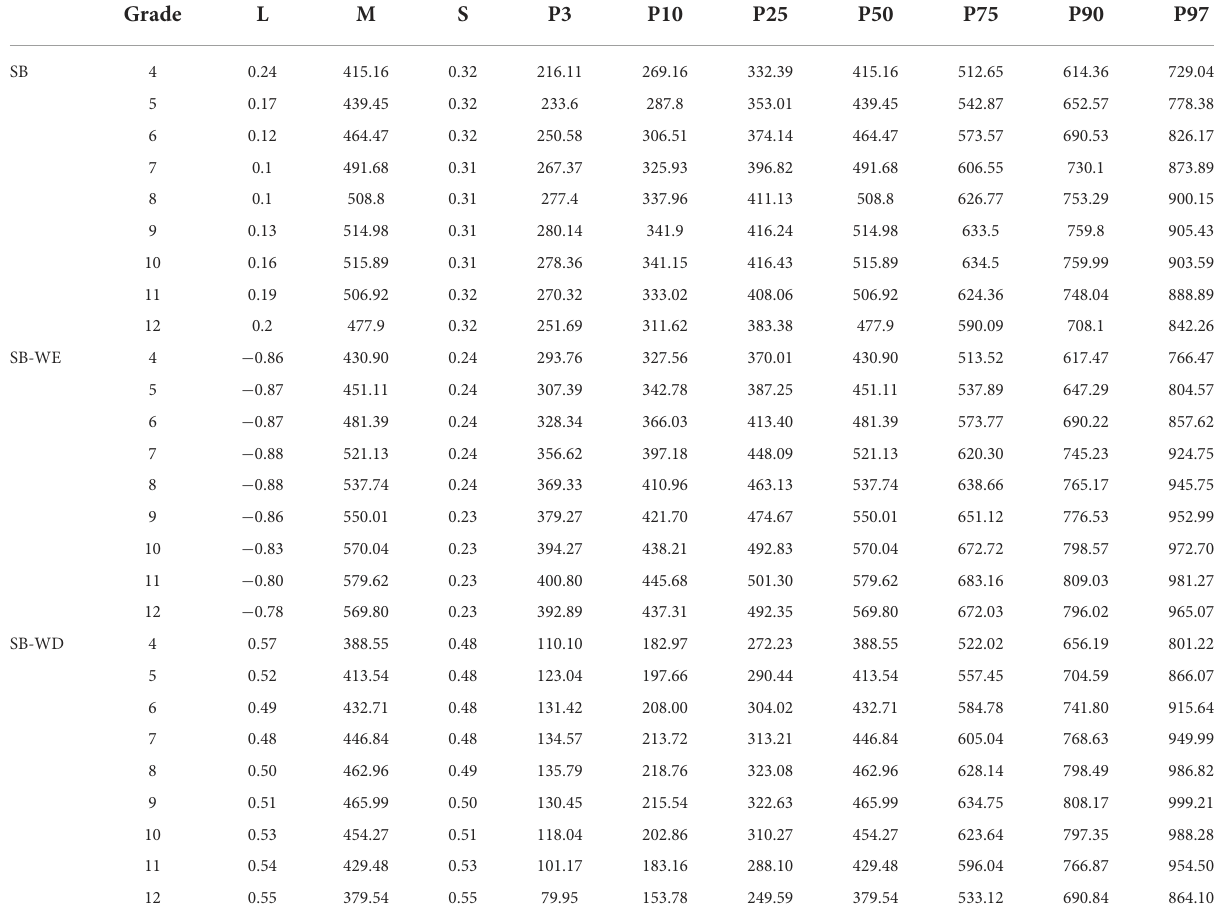
TABLE 3 Percentile distribution of sedentary time among Chinese children and